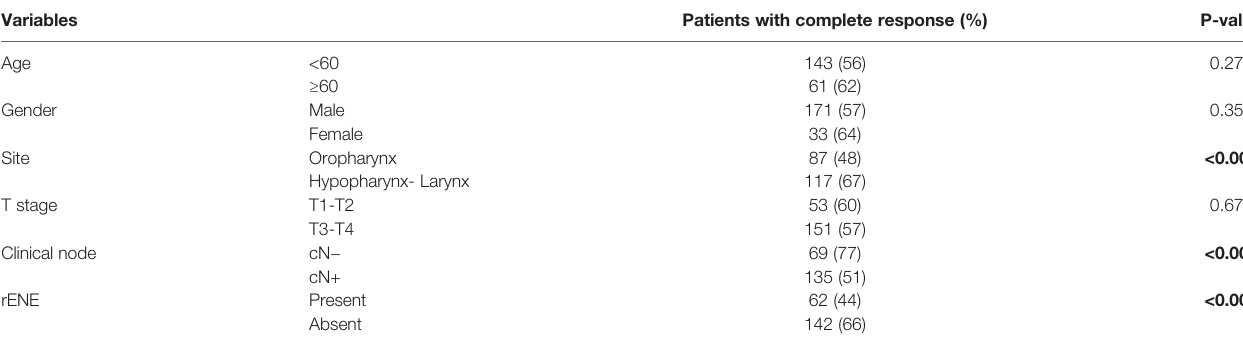
TABLE 5 | Univariate analysis to determine the factors predicting complete response. Variables